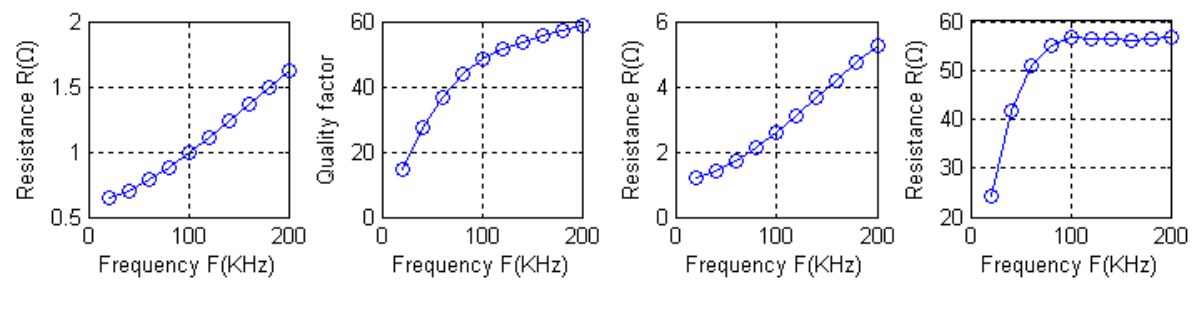
Figure 19. AC impendence and quality factor on the function of